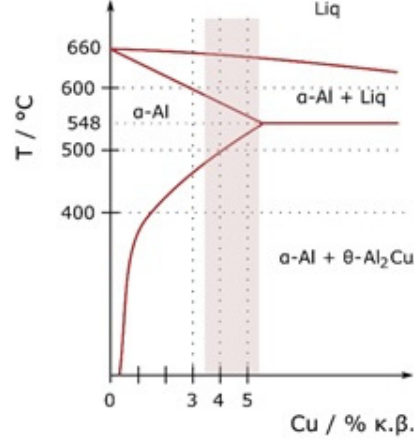
Figure 1. Al–Cu phase diagram [17].